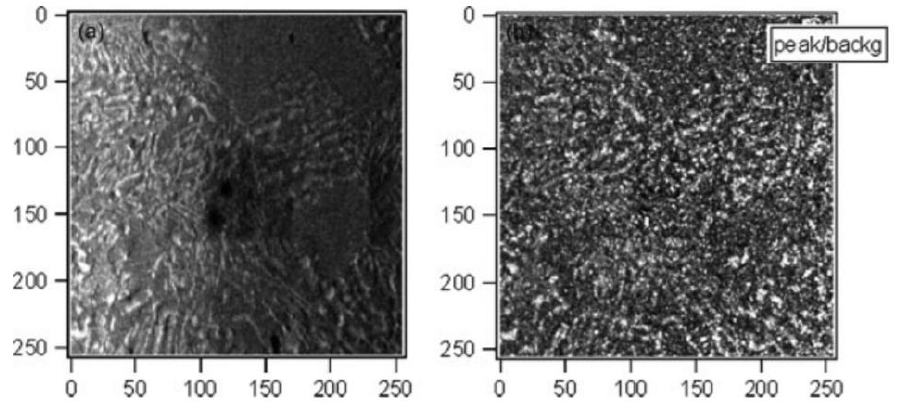
Figure 27. SPEM Cr 3p chemical images (51.2 × 51.2 µm 2 ) of the sample treated for 23 h at 850 °C: ( a ) as-acquired and ( b ) corrected for the sample topography by calculating the ratio peak/background for Cr 3p signal [40].